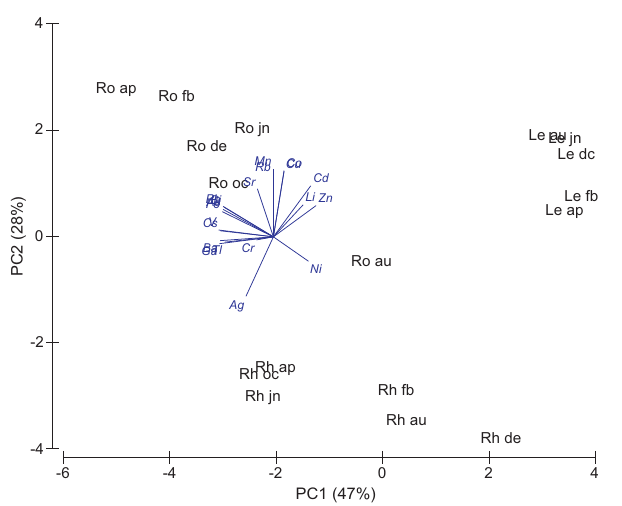
Fig. 3. Principal component analysis (PCA) of P. oceanica com- partments that are physiologically connected (leaves, rhizomes and roots) for each sampling event based on element concentrations. Acronyms are explained in the caption of Fig. 2. Note that the names of some trace elements are plotted very close to each other, this is the case of (from top to bottom in a counterclockwise direction) Co and Cu; Mn and Rb; As, Bi, Fe and Pb; Cs and V; Ba, Ga and Tl.